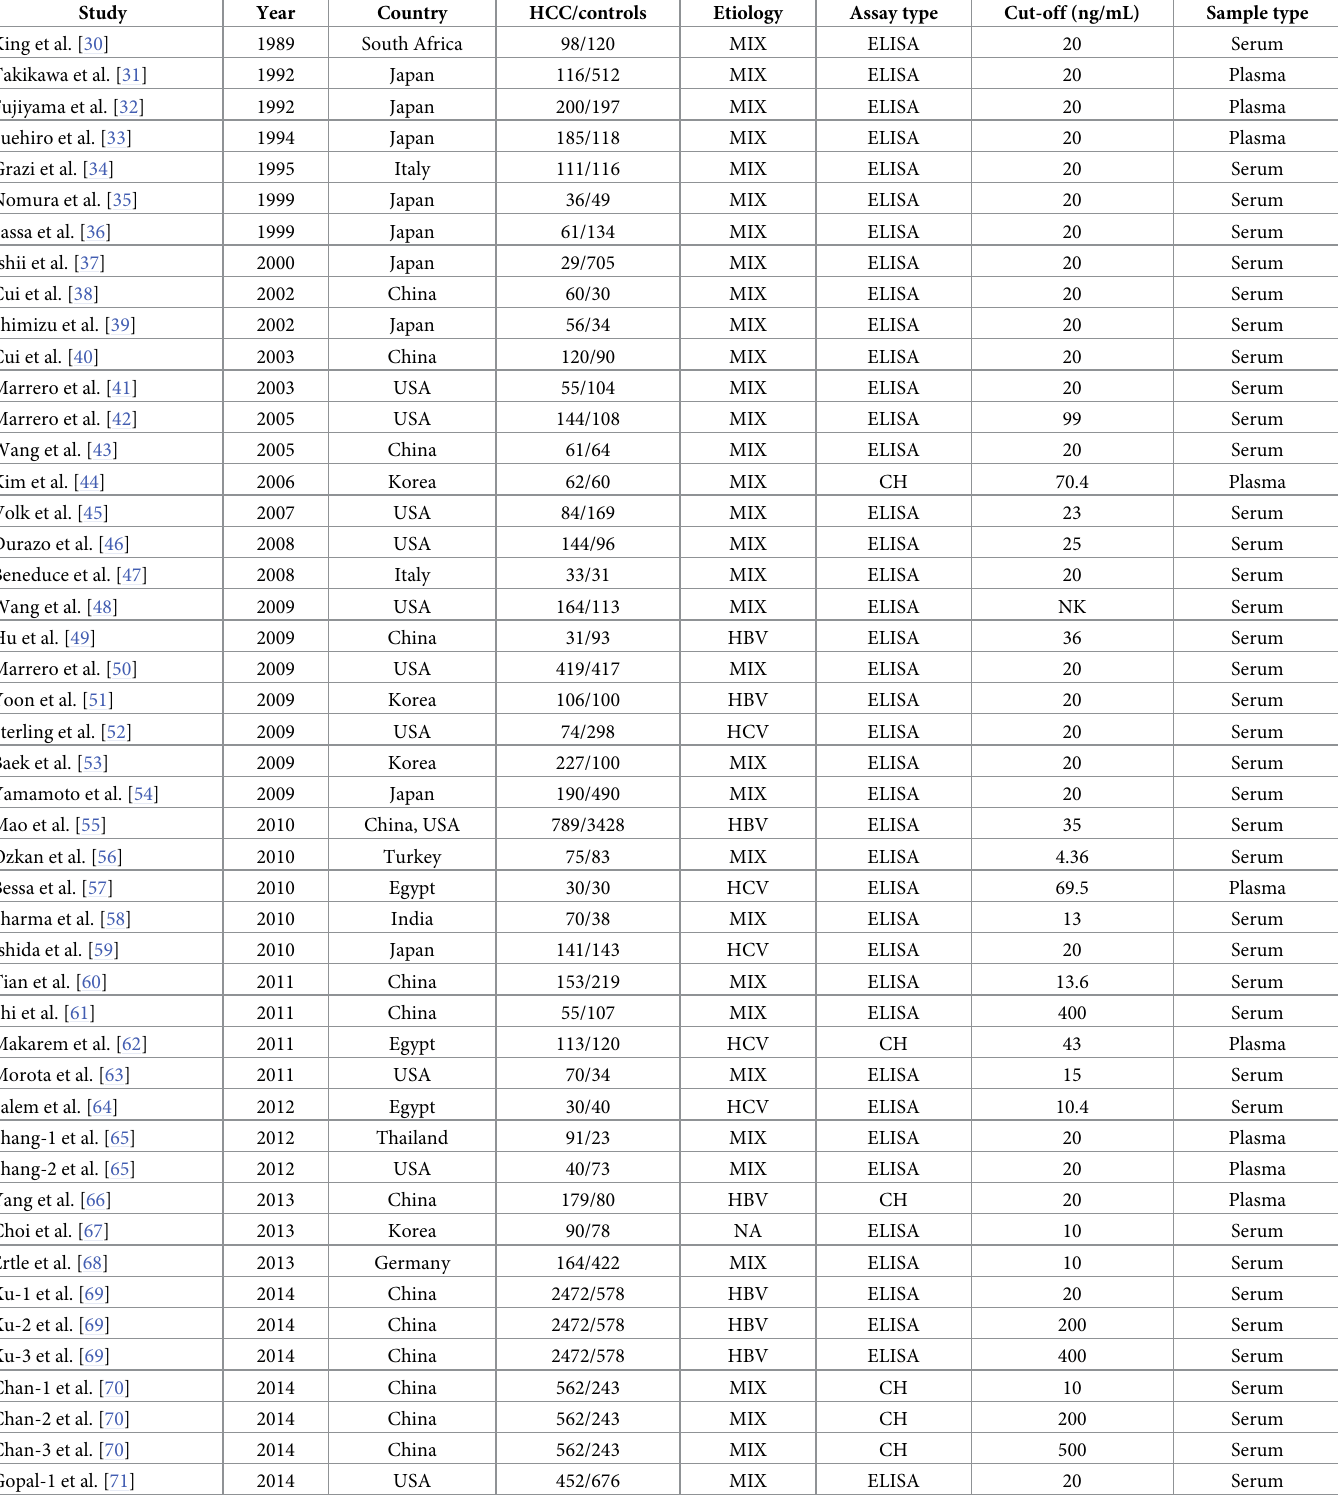
Table 1. Characteristics of studies included in the